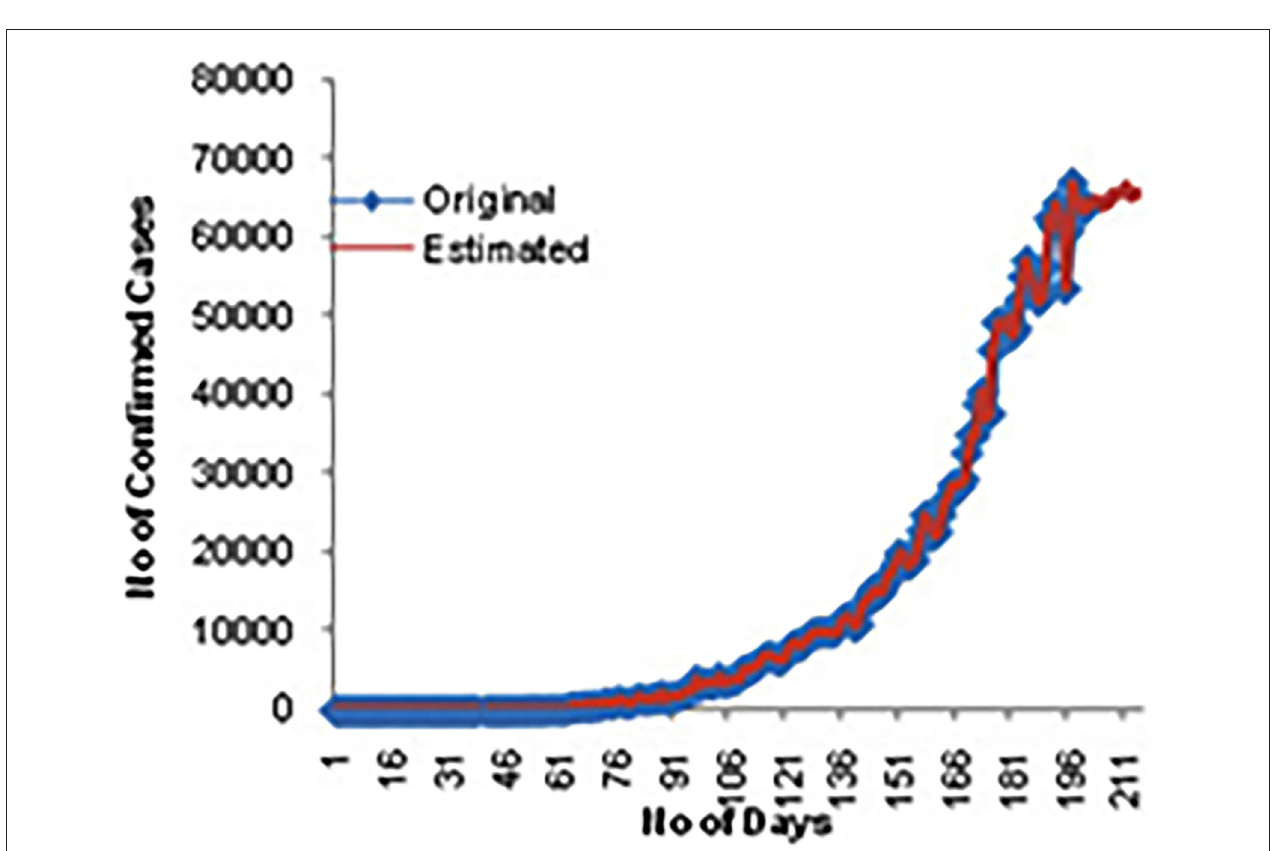
FIGURE 6 | Estimated confirmed cases for 15